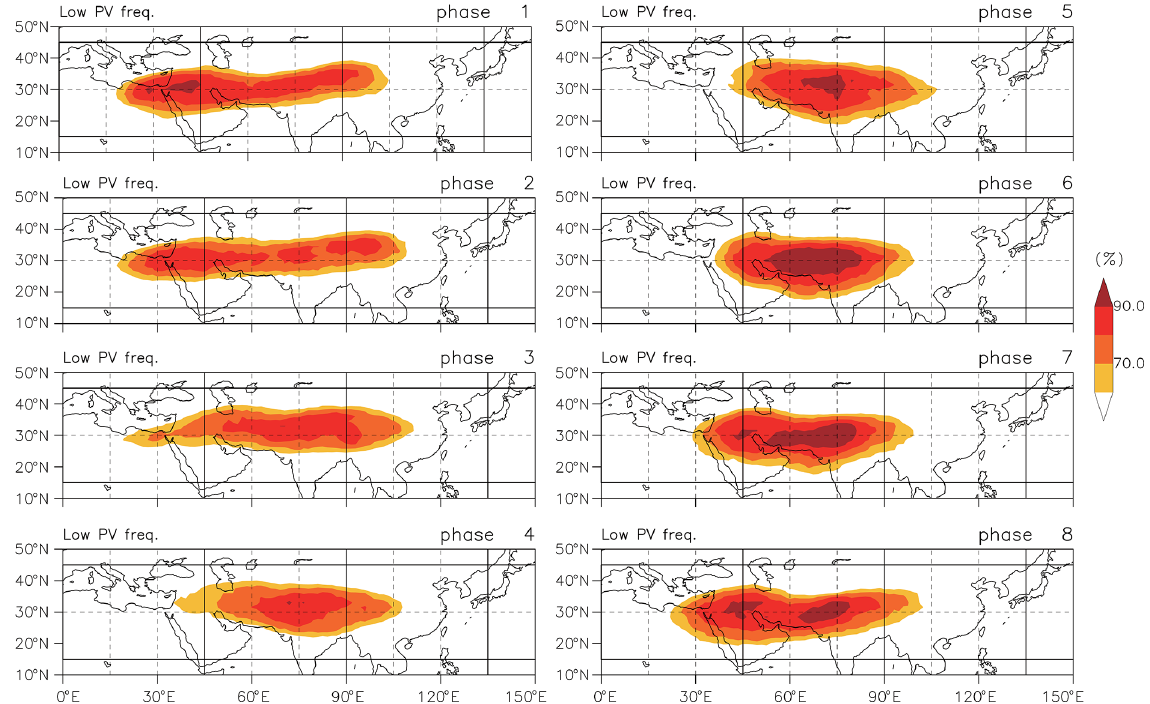
Figure 11. Percentage of PV value lower than the reference value of 2.0PVU at the 370K isentropic level for each phase.